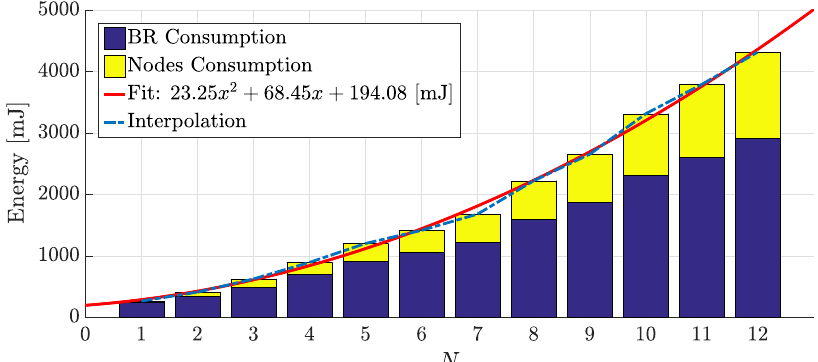
Figure 5. Energy spent by the overall network during the SCR-RES phase with CCR set to 8 Hz (metric EN-SCR-RES). Bars show the amount of energy spent by BR and nodes.